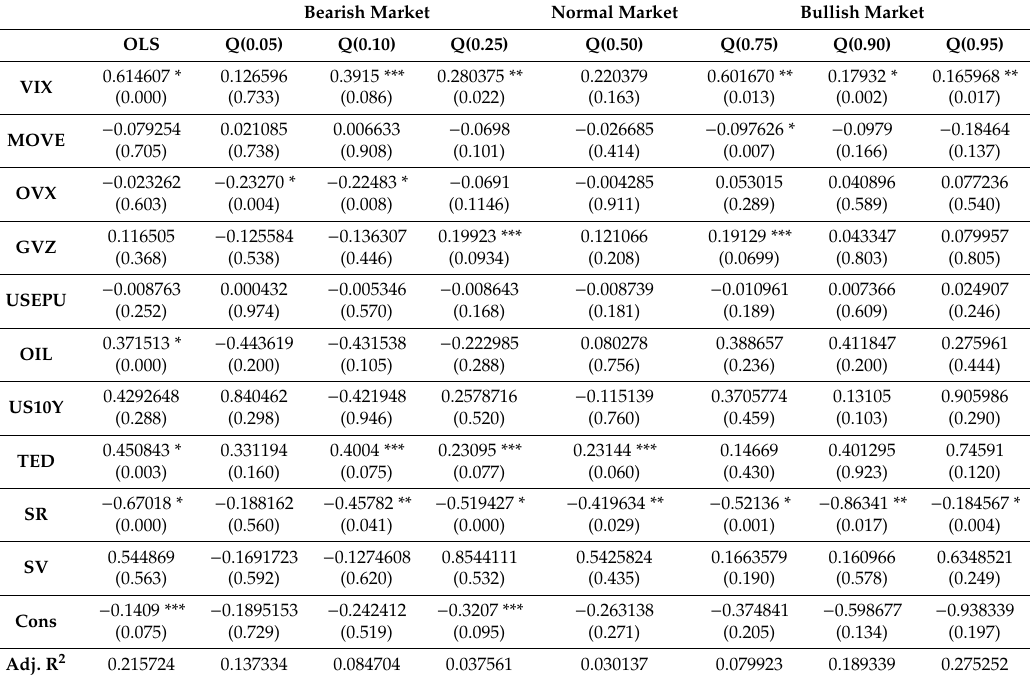
Table 4. Quantile regression estimates for Saudi